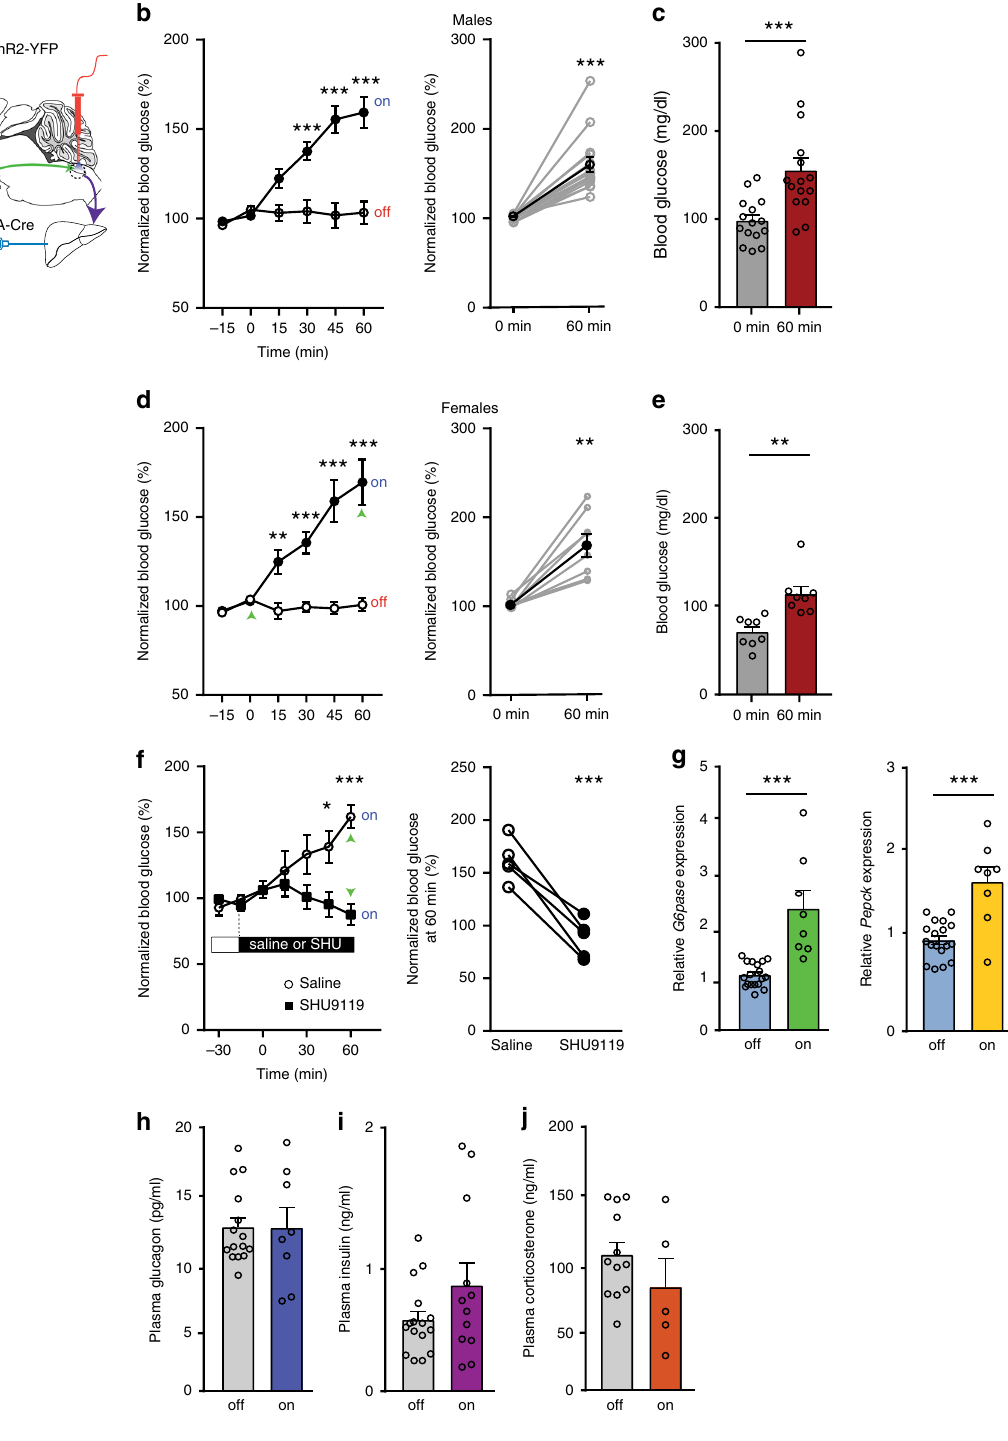
insulin secretion (GSIS) as inhibition of liver-projecting cholinergic nerves signi fi cantly elevated blood glucose that may activate the counterregulatory response. There were no signi fi cant differences in plasma epinephrine and corticosterone levels between the two groups (Supplementary Fig. 8a, b). Inhibition of parasympathetic cholinergic input did not change plasma lactate levels in both male and female mice (Supplementary Fig. 8a, b). Therefore, our results support the interpretation that reduced activity of liver-projecting cholinergic neurons elevates blood glucose levels in a pancreatic hormone-independent